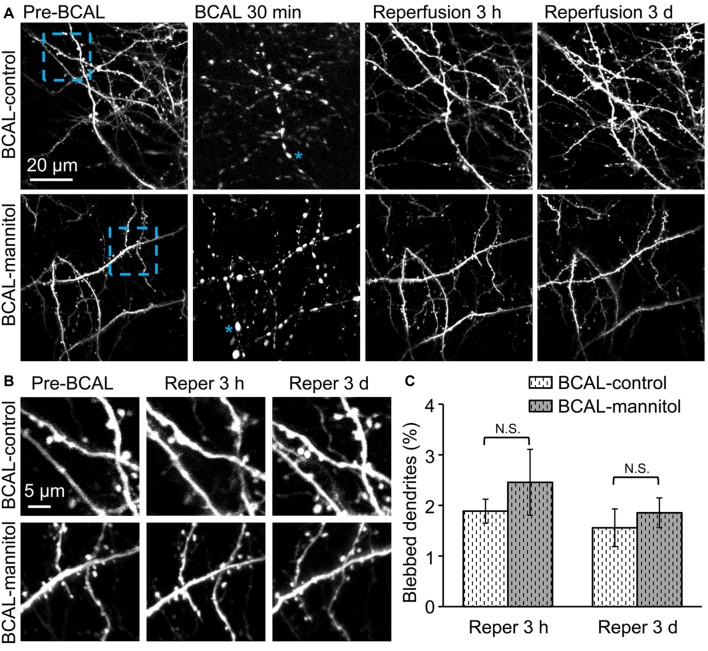
Mannitol did not affect the reversible recovery of the dendritic structure following global cerebral ischemia/reperfusion. (A) Morphological changes in dendritic structures before ischemia, 30 min after ischemia, 3 h and 3 days after reperfusion. Note that most of the blebbed dendrites recovered at 3 h after reperfusion. Asterisk (*) indicates blebbed dendrite. (B) Magnified view of the blue-boxed region in (A) showing dendritic structures before ischemia, at 3 h and 3 days after reperfusion. Note that mannitol-induced extravasation did not affect the reversible recovery of the dendritic structures. (C) Quantification of the percentage of blebbed dendrites in ischemic animals treated with mannitol or saline at 3 h and 3 days after reperfusion (n = 6 mice, each group). Note that there is no significant difference in dendritic beading in mannitol-injected mice and saline-injected mice. N.S., p > 0.05.